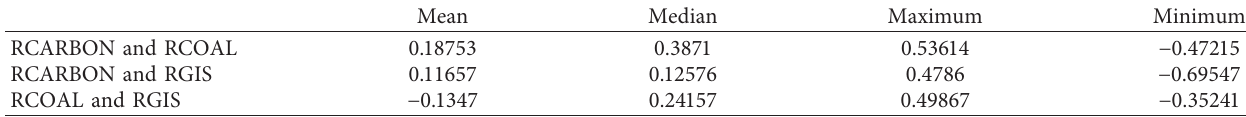
Table 7: Descriptive statistics of dynamic conditional correlation coefficient.